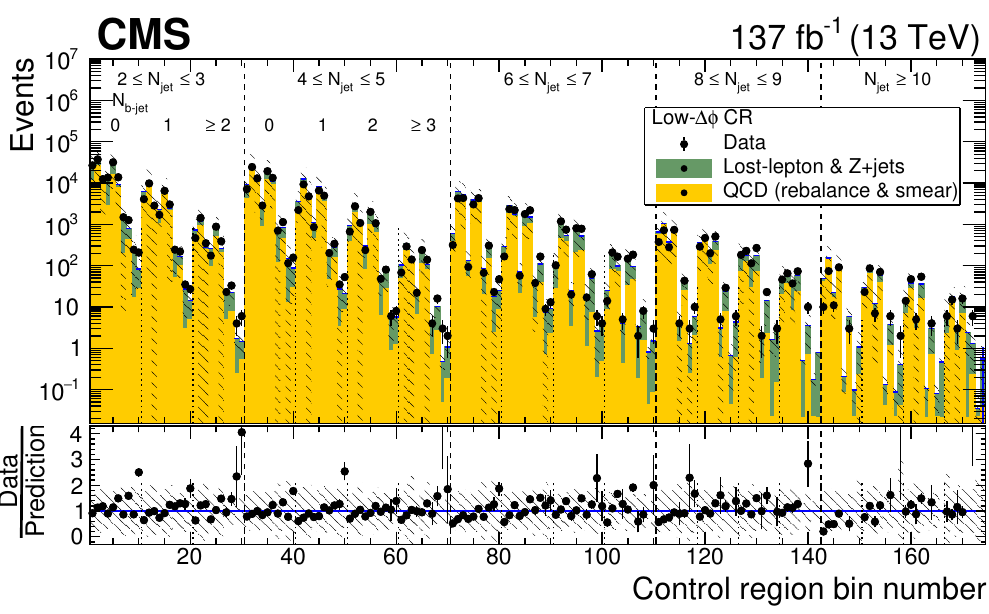
Figure 9 . Distribution of observed and predicted event yields in the inverted-(cid:1) (cid:30) control region analysis bins. The uncertainties are statistical only. The labeling of the bin numbers is the same as in (cid:12)gure 7. The lower panel shows the ratio of the observed to the predicted event yields, with their statistical uncertainties. The hatched region indicates the total uncertainty in the prediction, with statistical and systematic uncertainties combined in